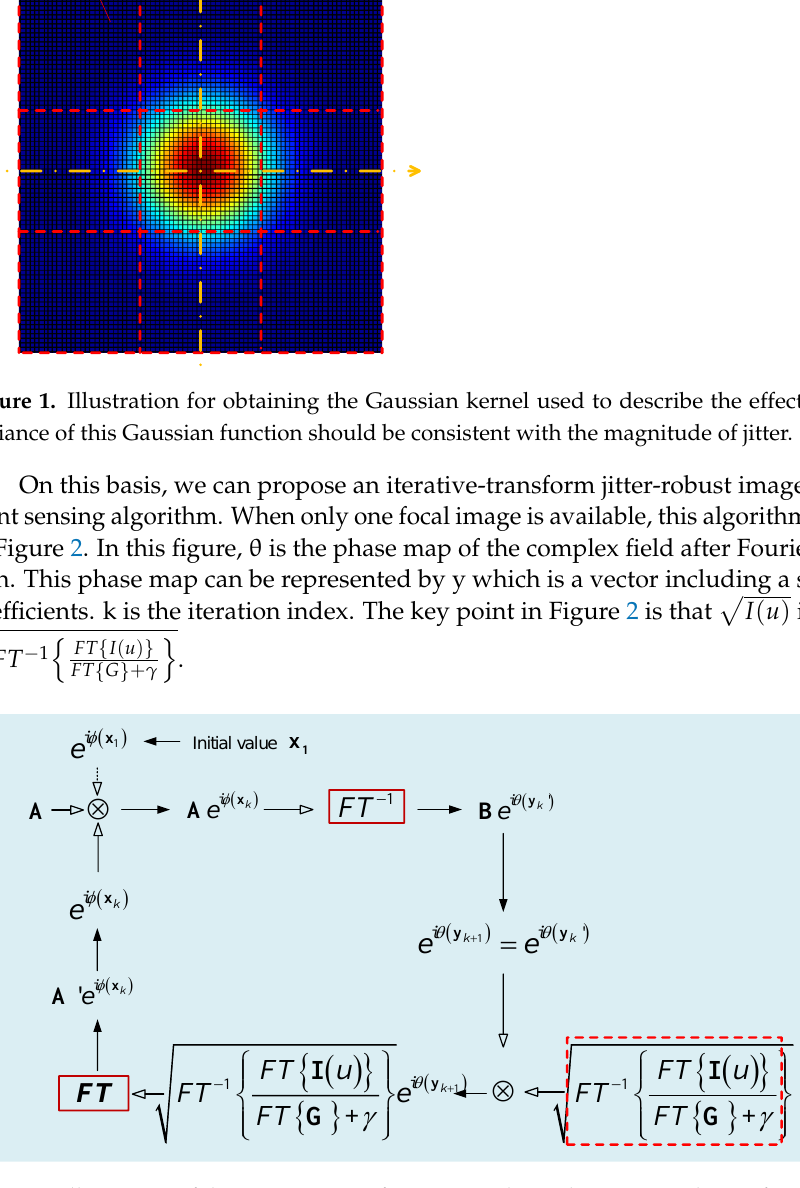
Figure 2. Illustration of the iterative-transform jitter-robust phase retrieval wavefront sensing.